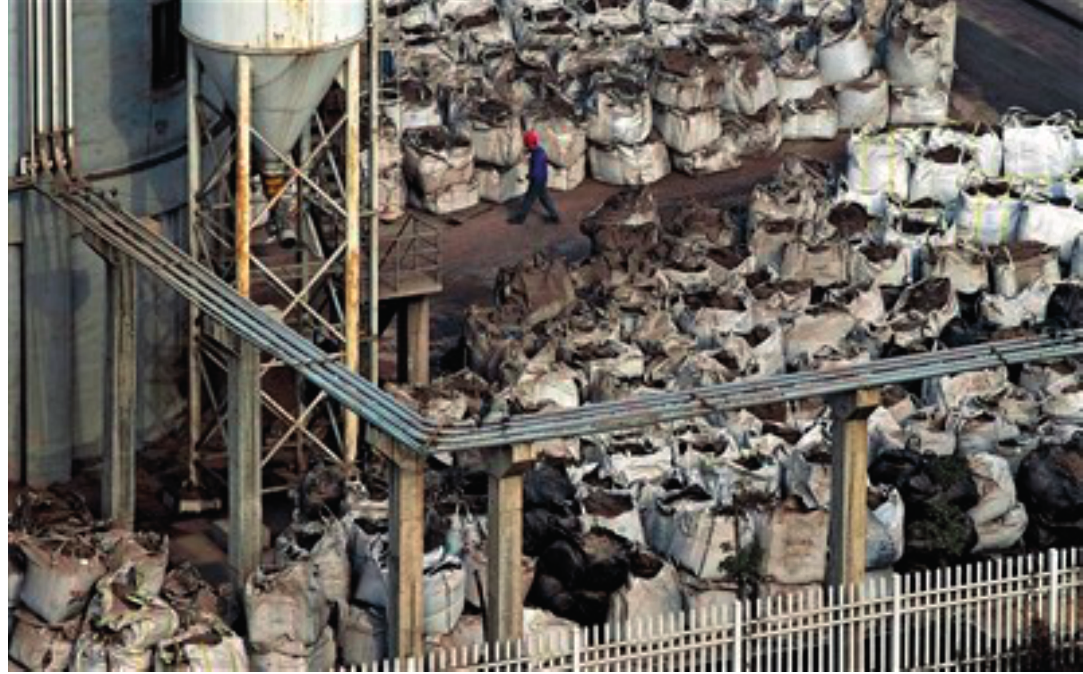
Figure 4. Fly ash in the open space of the Guodingshan waste incineration